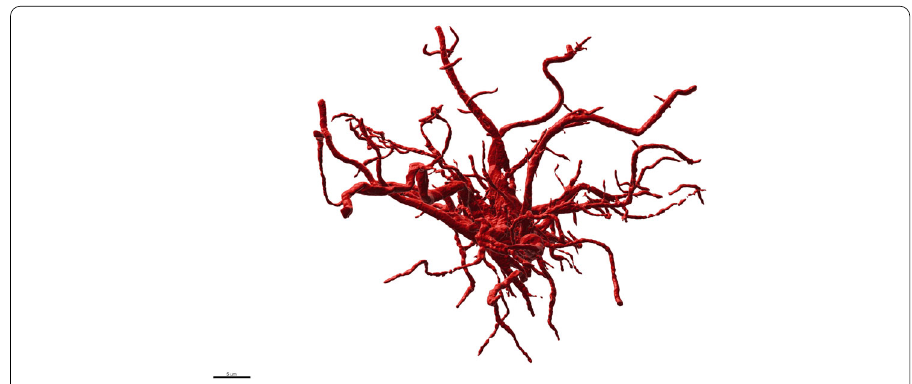
Fig. 1 The complex morphology of an astrocyte from a human post mortem sample obtained by fluorescent (GFAP) super-resolution light microscopy [63] and reconstructed by the machine learning based tool MicMac